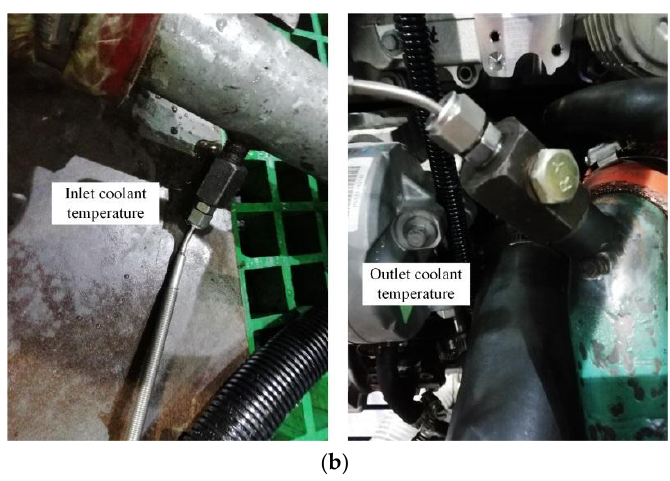
Figure 2. Experiment setup and measuring points: ( a ) engine test rig and cylinder head measuring points; ( b ) inlet and outlet temperature measuring point. Table 1. Operation conditions of engine experiment.